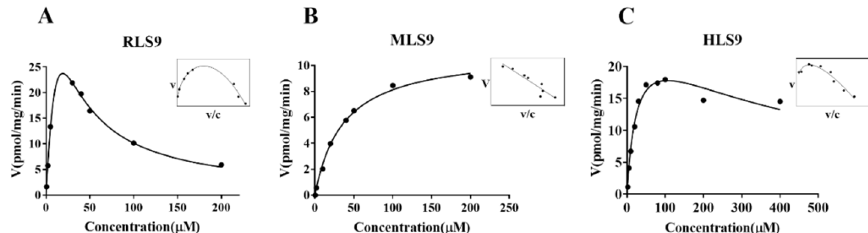
Figure 3. Enzyme kinetic analysis for the magnolol sulfation by RLS9 ( A ), MLS9 ( B ) and HLS9 ( C ). In each figure, the inset shows the Eade–Hofstee plot. Each point is the average of three determinations, and the error bar is the standard deviation of the mean. Table 2. Kinetic parameters derived for magnolol sulfation in liver S9 fractions from different species. Data represents the mean ± standard deviation of three determinations. SI stands for the substrate inhibition model.